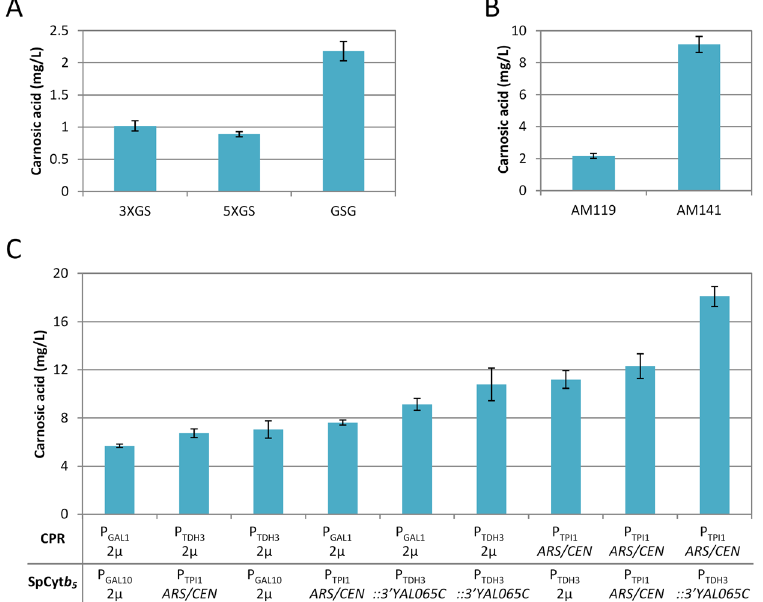
Figure 3. Optimization of carnosic acid production in yeast. ( A ) Production of carnosic acid was evaluated using linkers of different size between the M1 and M2a module-specific parts. 2-fold improvement was achieved using the GSG tripeptide linker (M1-GSG-M2a). ( B ) Expression of SpCyt b 5 from a single chromosomal copy (strain AM141) further increased the CA yield by 4-fold. ( C) Balancing the CPR/SpCyt b 5 expression further increased carnosic acid production to 18 mg/L. CPR and SpCyt b 5 were expressed from chromosomal integration ( ::3 ′ YAL065C ), from a low copy-number plasmid ( ARS/CEN ), or from a high copy number plasmid (2 μ ), under the control of constitutive (P TPI1 or P TDH3 ) or inducible (P GAL1 or P GAL10 ) promoters of different strength (P TPI1 – medium or P TDH3 , P GAL1 or P GAL10 – strong).